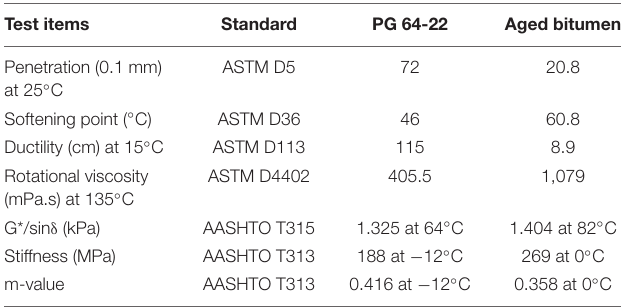
TABLE 2 | The properties of virgin and aged bitumen.